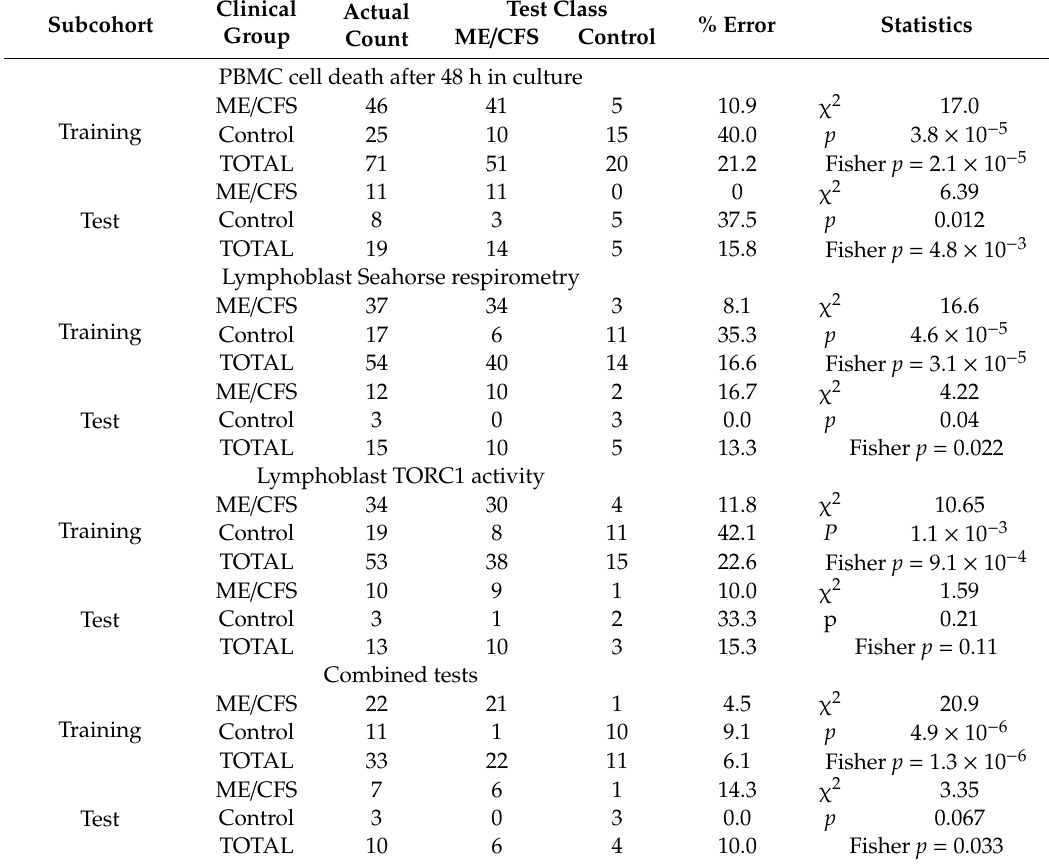
Table A2. Confusion matrix for logistic regression of PBMC and lymphoblast ME / CFS biomarkers using a randomly selected training and test